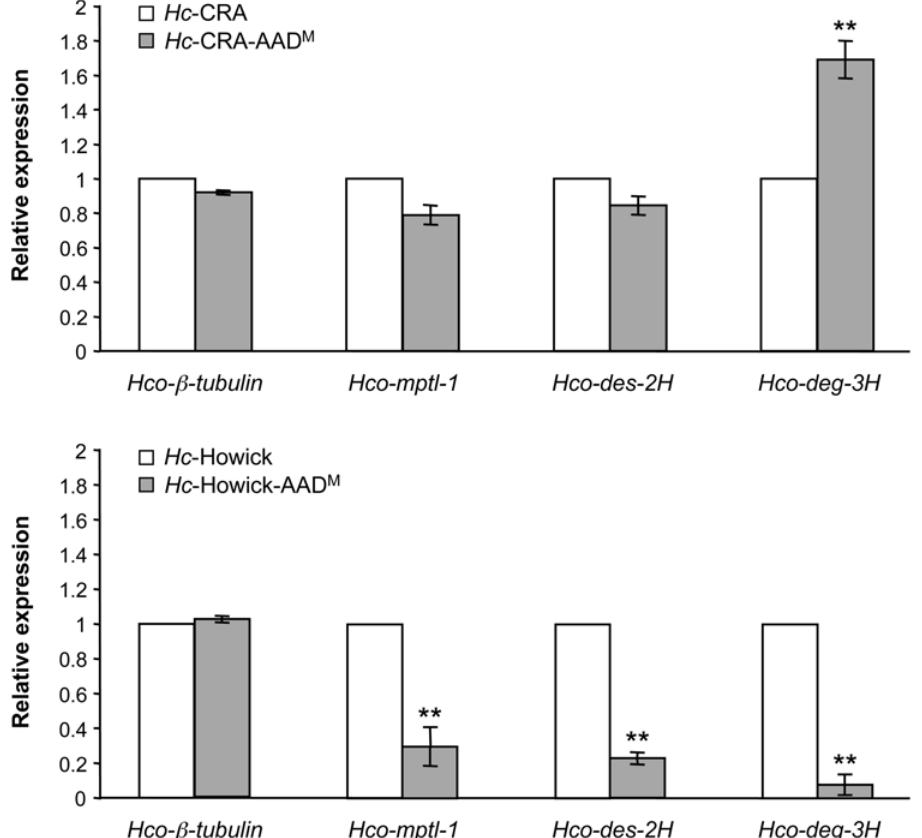
Figure 7. Relative mRNA levels of DEG-3 subfamily genes in AAD mutant H.contortus . Relative expression levels of the DEG-3 subfamily nAChR genes Hco-mptl-1 , Hco-des-2H , and Hco-deg-3H quantified by RT-qPCR for Hc -CRA and Hc -CRA AAD M (top), or Hc -Howick and Hc -Howick AAD M isolates (bottom). Relative expression values were normalized to those of glucose-phosphate isomerase (GPI); ß-tubulin served as a non-affected control. P-values ( , 0.01 are indicated by **) were calculated with repeated measures Anova, followed by Dunnett’s test against the parental control (which had been set to 1). Average mRNA levels and SD were derived from 3 independent experiments, each in duplicate with 1 qPCR run each.